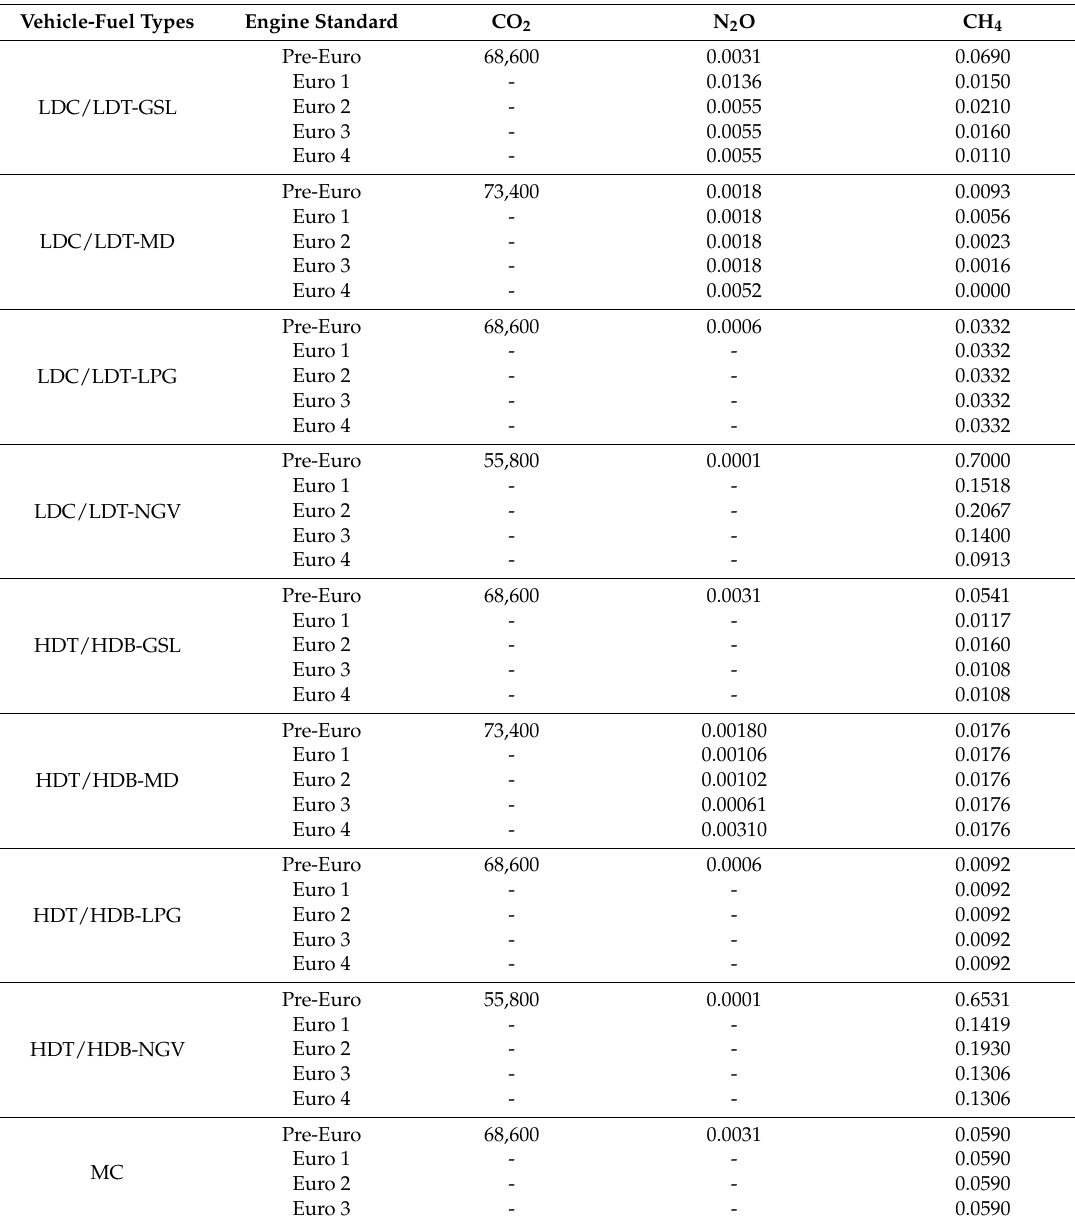
(b) Emission Factor of GHG Emissions (Unit: kt